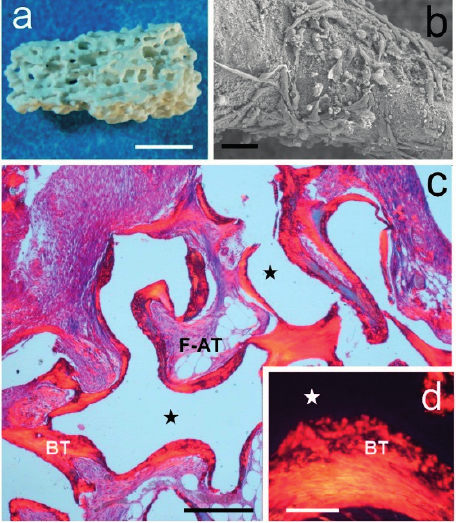
Figure 1. In vivo ectopic bone formation assay. ( a ) General view of the shape, size, and porosity of a single mineral scaffold (Pro Osteon 500) used as a grafting material alone and with added cells. Bar = 2 mm; ( b ) Scanning electron microscopy (SEM) image showing bone marrow-cultured cells attached to a mineral scaffold covered with fibronectin ready for transplantation. Bar = 20 µm; ( c ) Histology of a scaffold seeded with MSCs transplanted on dorsal surface of a nude mouse and recovered four weeks later. Scaffold ( ★ ) is outlined by a bone tissue layer (BT) and fibroadipose tissue (F-AT). Sirius red staining. Bar = 200 µm; ( d ) Bone tissue examined with polarization microscopy shows a woven-fibered matrix. Bar = 50 µm.